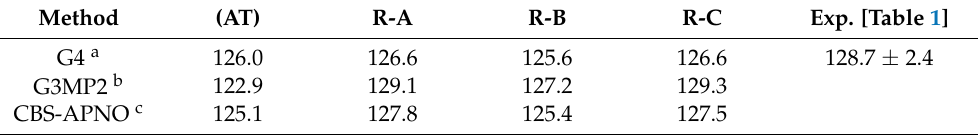
Table 2. Results of the quantum chemical calculations of ∆ (cid:2916) 𝐻 mo (g, 298.15 K) for 3-methyl-indole with